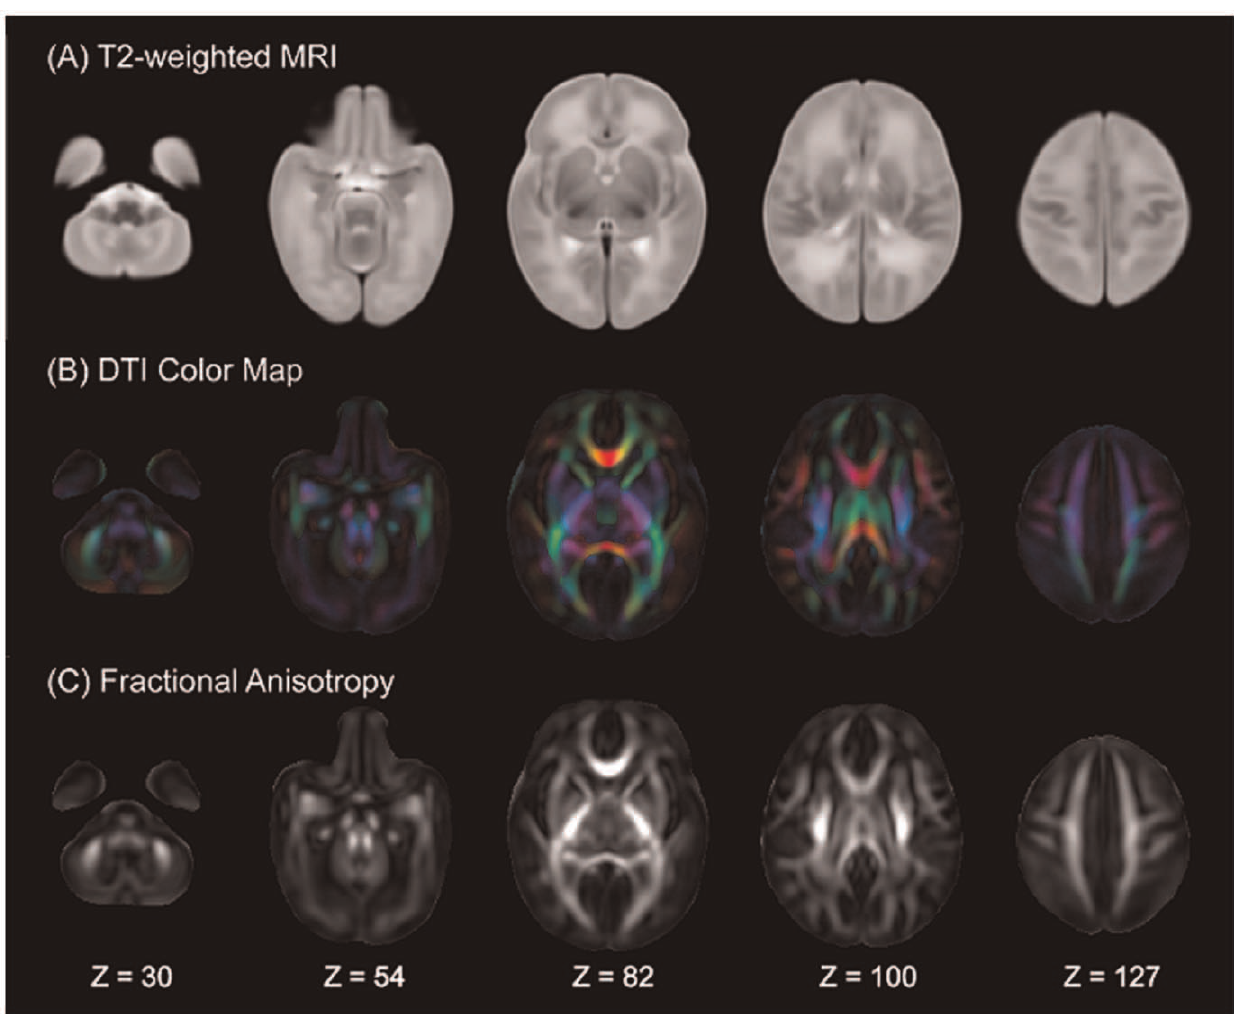
Figure 1. Neonatal structural MRI and DTI atlases. Rows (A-C) respectively show the axial slices of the T2-weighted MRI, the DTI color map and fractional anisotropy (FA) atlases. The anatomical coordinates of individual axial slices are listed on the bottom of the figure.